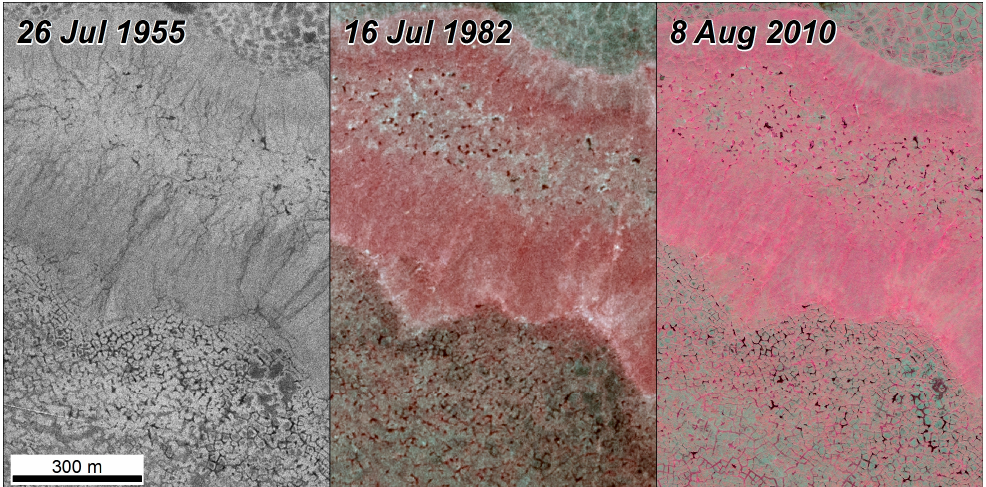
Figure 5. Thaw pit development at Kugachiak site on yedoma uplands (top half of images) and alluvial-marine deposits (bottom) of the Chukchi coastal plain, 1955–2010, North Slope, Alaska.